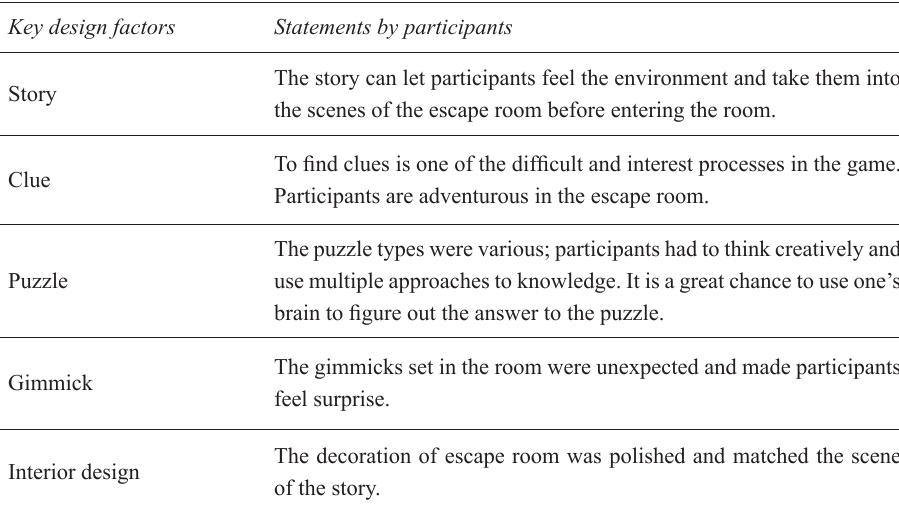
Table 8. Summary table of key design factors of escape room design (N. of group =